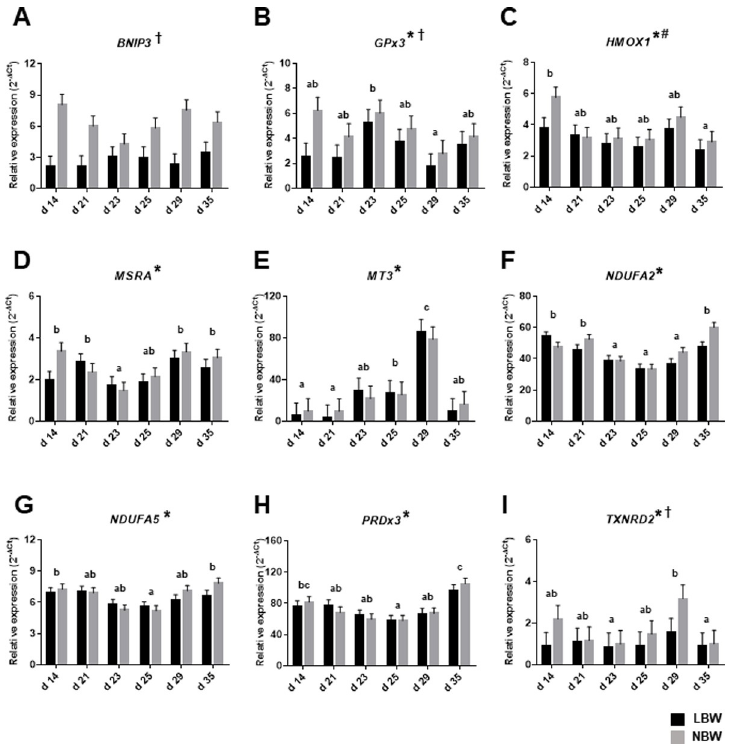
Fig 1. Relative mRNA levels of BNIP3 , GPx3 , HMOX1 , MRSA , MT3 , NDUFA2 , NDUFA5 , PRDx3 and TXNRD2 were analyzed in liver of LBW and NBW piglets of different ages throughout the peri-weaning period. Bars in the graphs represent least-square means ± SEM of 10 piglets. Asterisk ( � ) indicates a significant effect of the age on means at P � 0.05. Dagger (†) indicates a significant effect of the birth weight on means at P � 0.05. Pound (#) indicates that means tended to be affected by birth weight at P < 0.10. In all cases, the interaction between age and birth weight is not significant P > 0.05. Detailed P-Values for main effects and interactions are available in S15 Table in S1 File and comparative analysis with litter and gender as random cofactors in S16 Table in S1 File and box plot of raw data distribution in S3 Fig in S1 File. Ages with different letters (a, b, c, d) within the graphs are statistically different at P � 0.05. LBW = low-birth weight piglets; NBW = normal-birth weight piglets; (A) BNIP3 = BCL2 interacting protein 3; (B) GPx3 = glutathione peroxidase 3; (C) HMOX1 = heme oxygenase 1; (D) MRSA = methionine sulfoxide reductase A, (E) MT3 = metallothionein 3; (F) NDUFA2 = NADH ubiquinone oxidoreductase subunit A2; (G) NDUFA5 = NADH ubiquinone oxidoreductase subunit A5; (H) PRDx3 = peroxideroxin 3; (I) TXNRD2 = thioredoxin reductase